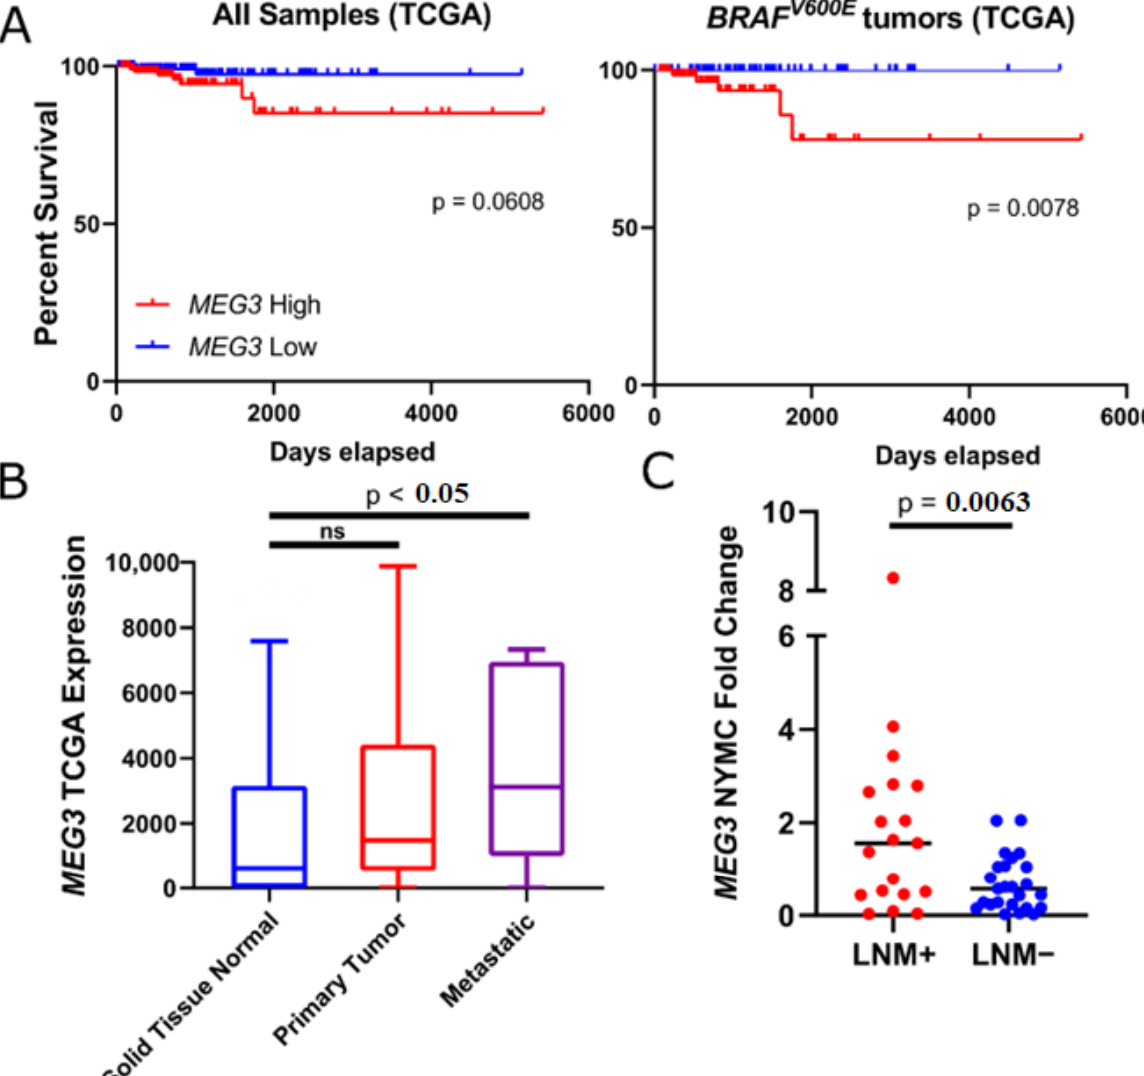
Figure 3. MEG3 expression is increased in PTC with LNM and correlates with poor outcomes ( A ) TCGA all patients (left) and BRAF V600E cohort (right) survival given top (red) and bottom (blue) quartile MEG3 expression. ( B ) TCGA Solid Tissue Normal MEG3 expression. ( C ) MEG3 fold-change expression in NYMC LNM+ and